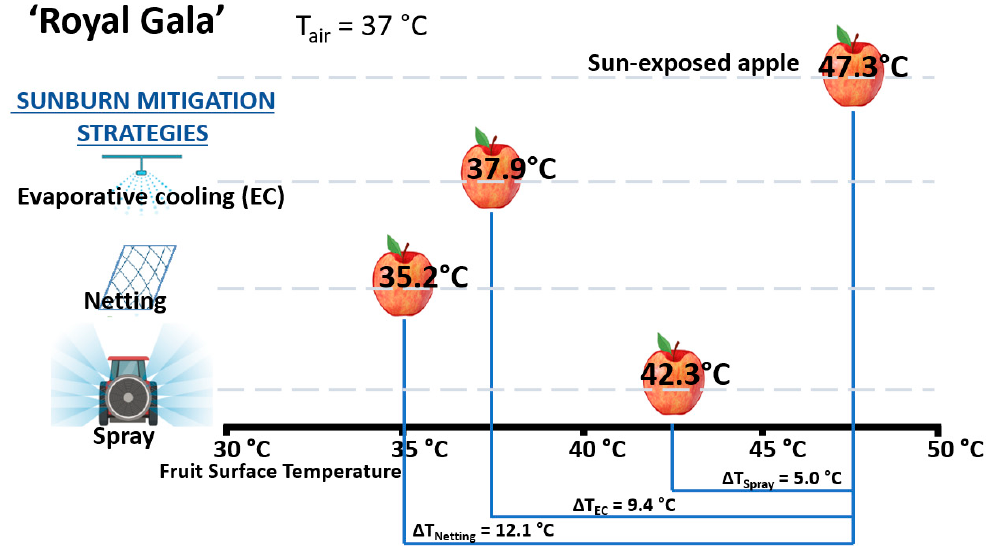
Figure 5. Comparisons of sunburn mitigation strategies on ‘Royal Gala’ fruit surface temperatures. Adapted from Gindaba and Wand [48].